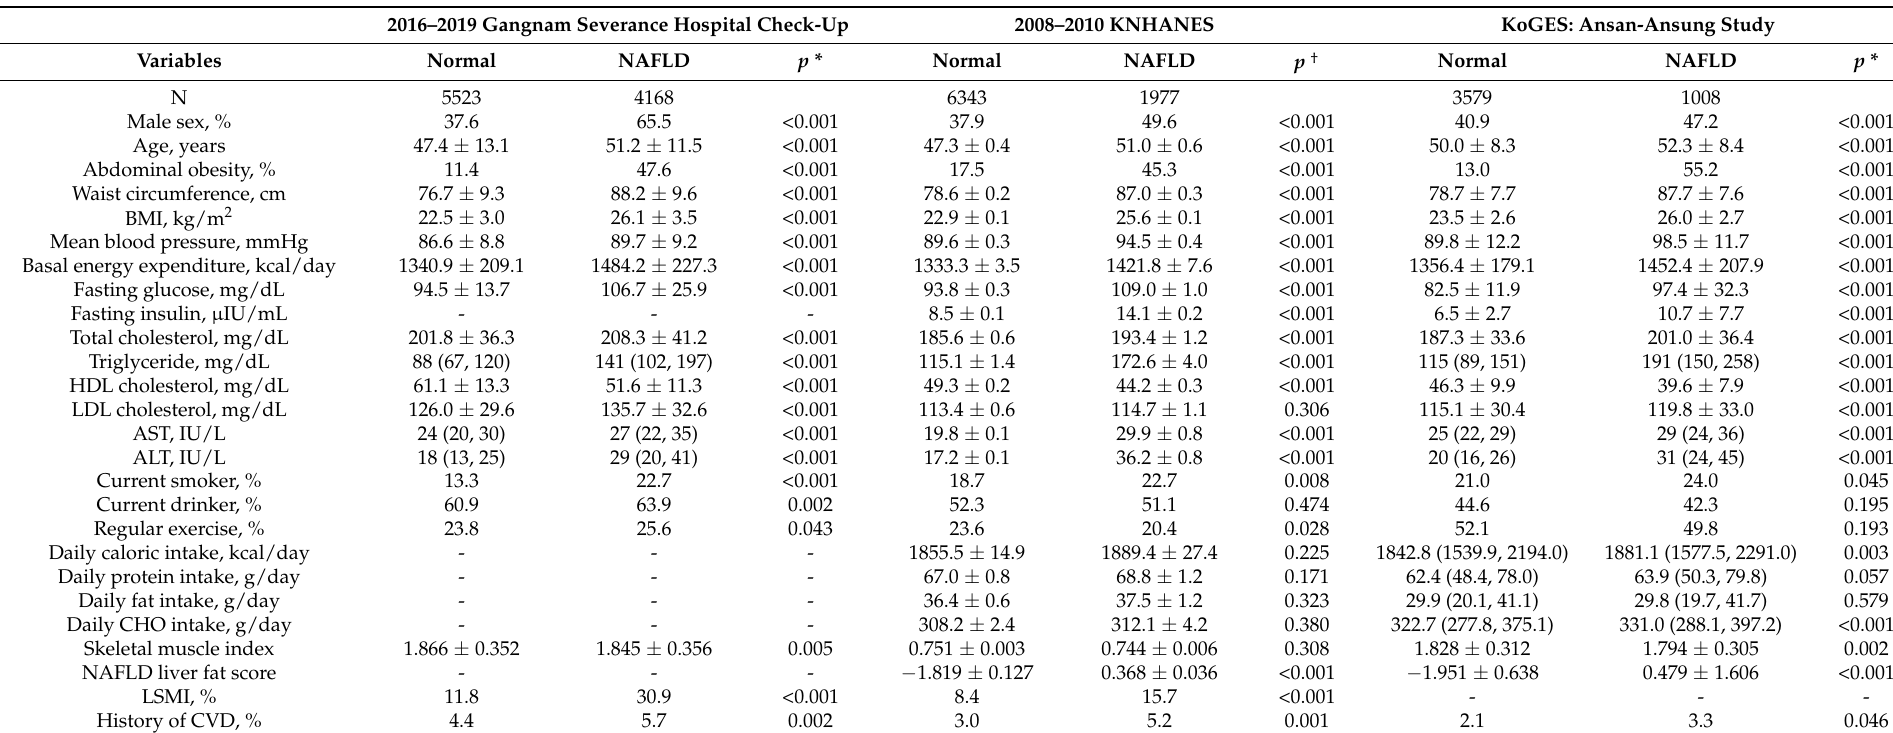
Table 1. Clinical characteristics of three different population cohorts according to non-alcoholic fatty liver disease (NAFLD)